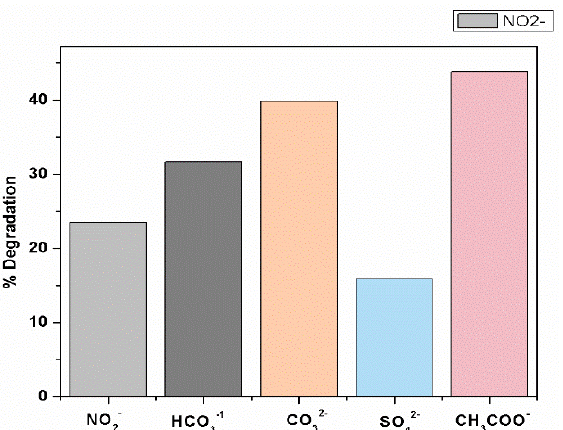
Figure 4. Effects of inorganic anions (NO 2 − , CO 32 − , HCO 3 − , SO 42 − , CH 3 COO − ) on the removal efficiency of CV by UV/PMS at [CV] ◦ = 0.01 mM, [NO 2 − ] ◦ = [CO 32 − ] ◦ = [HCO 3 − ] ◦ = [SO 42 − ] ◦ = [CH 3 COO − ] ◦ = 1 ppm, [pH] ◦ =